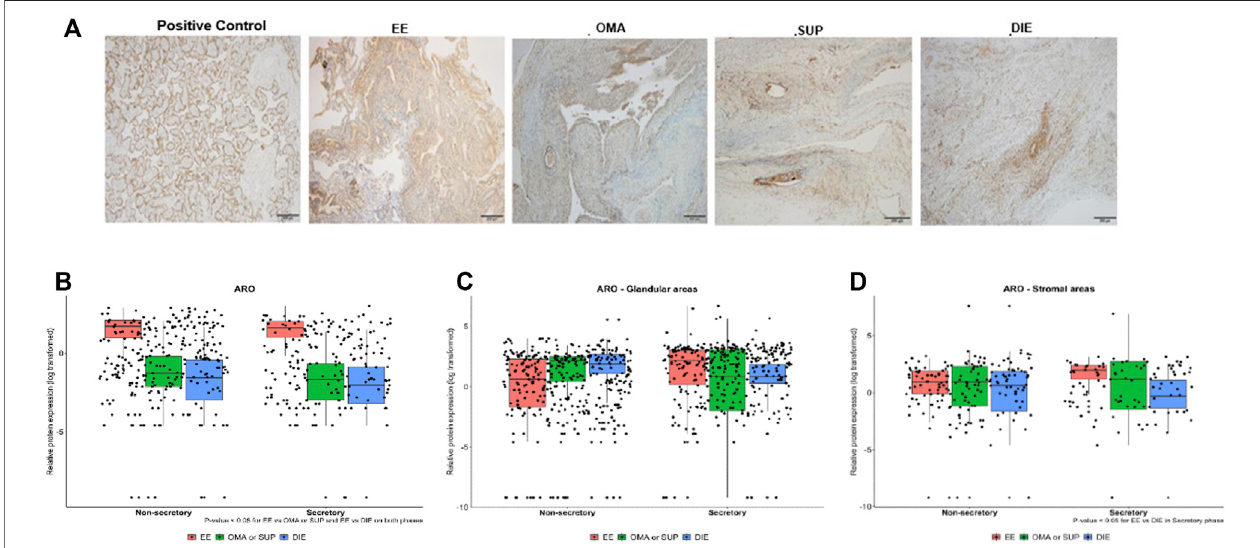
FIGURE 3 | Expression of aromatase in endometriotic lesions from different locations obtained in the secretory and nonsecretory phases. (A) Representative photomicrographs from IHC aromatase-stained sections of EE, OMA, SUP, and DIE endometriotic lesions and from the placenta (positive control). Aromatase protein expressionlevelsquanti fi edbyIHCinbiopsysectionsobtainedatnonsecretoryandsecretoryphasesofthemenstrualcycle: (B) wholesections, (C) glandularareas,and (D) stromalareas.Barsrepresentthelog 10 meanfoldchangeoftherelativeproteinexpression,accompaniedby95%CI.Statisticaldifferencesbetweengroupsare indicated by * p < 0.005. EE: eutopic-endometrium ( n = 23); OMA: ovarian ( n = 6); SUP: super fi cial ( n = 9); and DIE: deep-in fi ltrating ( n = 21) lesions from endometriosis patients. Group OMA/SUP: the analysis by IHC showed similar values and distribution for OMA and SUP lesions, and their data were joined into one group OMA/SUP ( n = 15) for statistical analysis purposes.